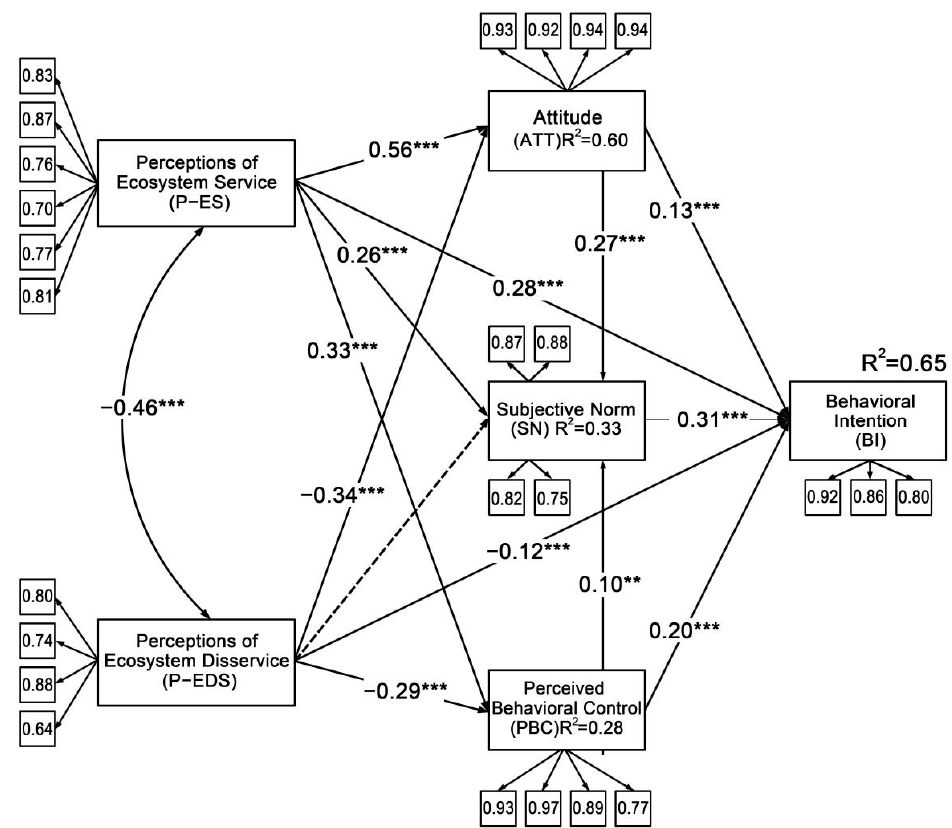
Figure 3. Possible causal relationships between perception of ecosystem service/disservice, attitude, subjective norm, perceived behavioral control, and behavioral intention; The dashed paths indicate removed hypothetical relationships leading to failed GOF measures; *** p < 0.001, ** p < 0.01